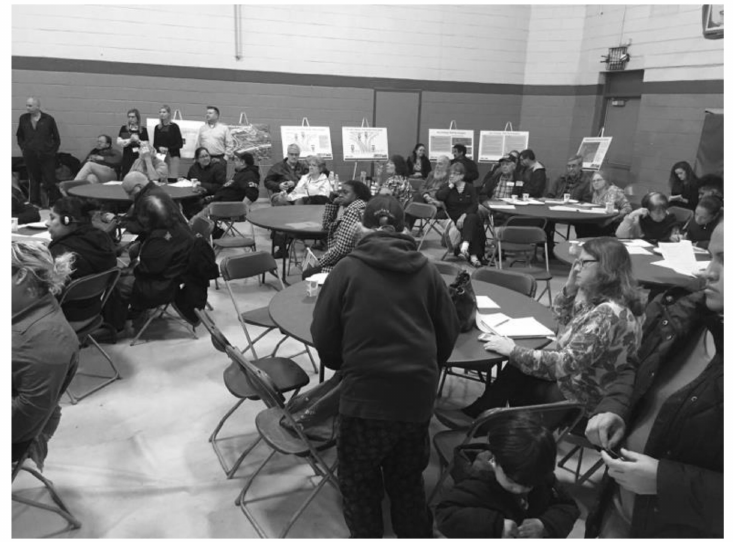
Figure 7. The Health Impact Assessment process built on existing mobilization e ff orts of the SW Detroit Community Benefits Coalition (CBC), and entailed much input from CBC members and the Resident Engagement Committee, as well as the GHIB Community Advisory Group. The HIA team attended several community meetings organized by the CBC to present on the proposed methods and preliminary findings, for